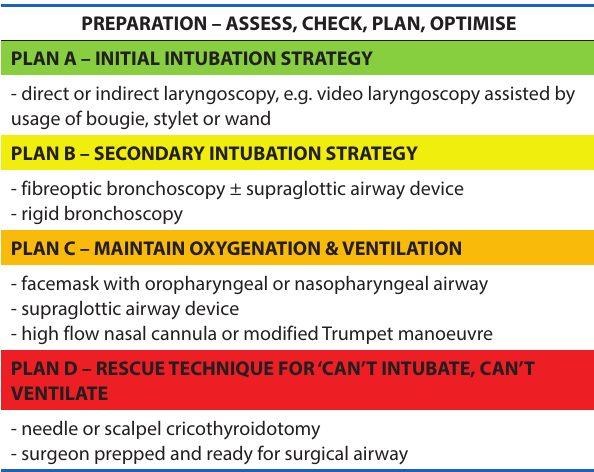
Table 2. Simplified airway algorithm 21 PREPARATION – ASSESS, CHECK, PLAN, OPTIMISE PLAN A – INITIAL INTUBATION